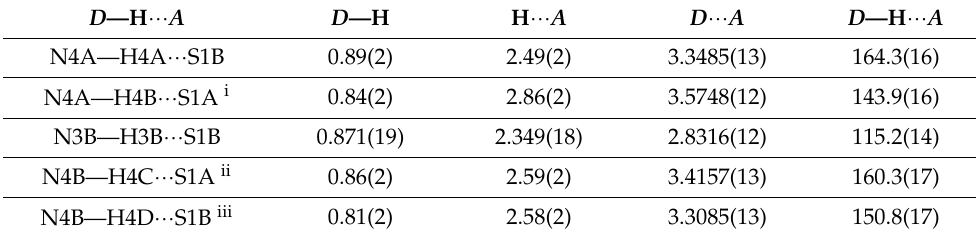
Table 10. Hydrogen-bond geometry (Å, ◦ ) for 8